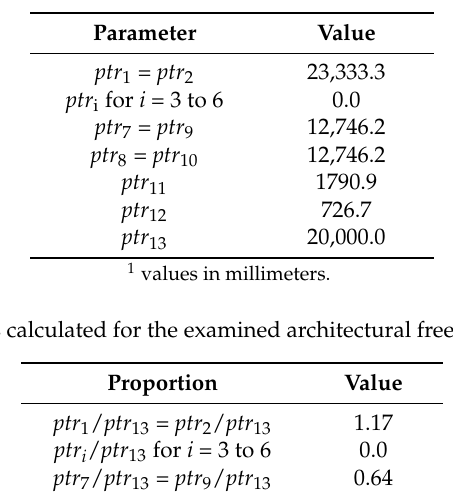
Figure 13. Simplified model of a building free form of the third type roofed with a transformed shell. Table 1. Parameters adopted for the examined architectural free form from Figure 13.